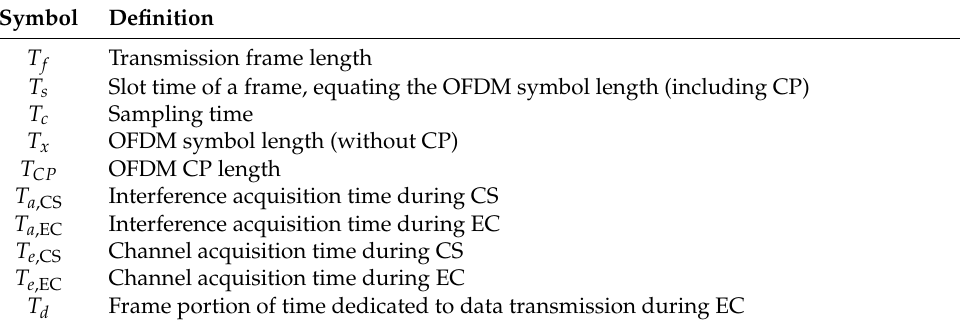
Table 1. List of variables related to time